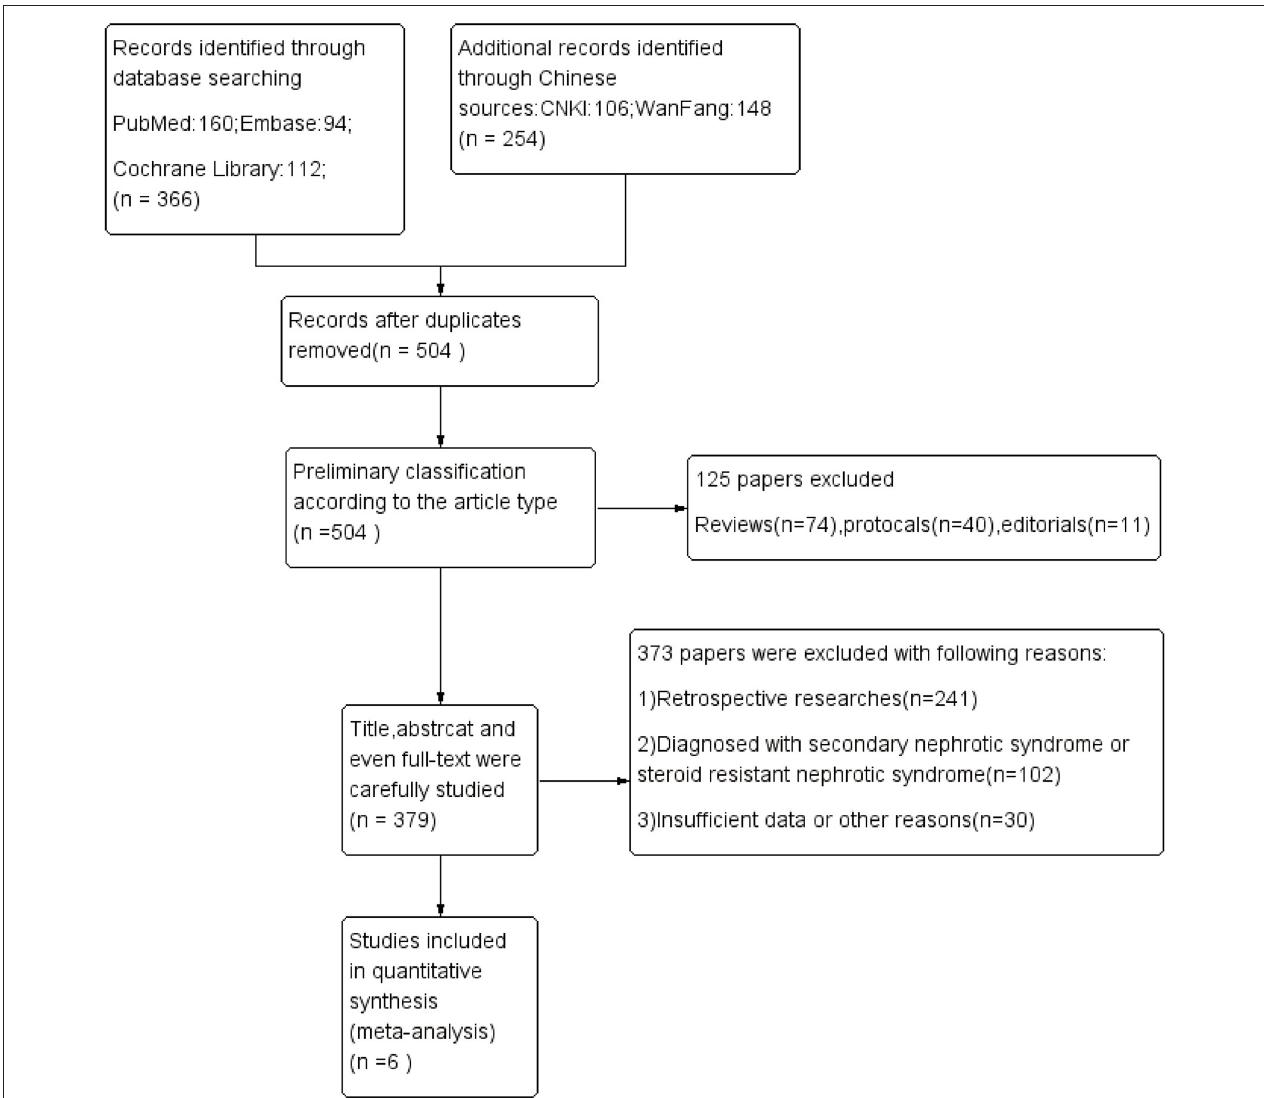
FIGURE 1 | Flow diagram of the study